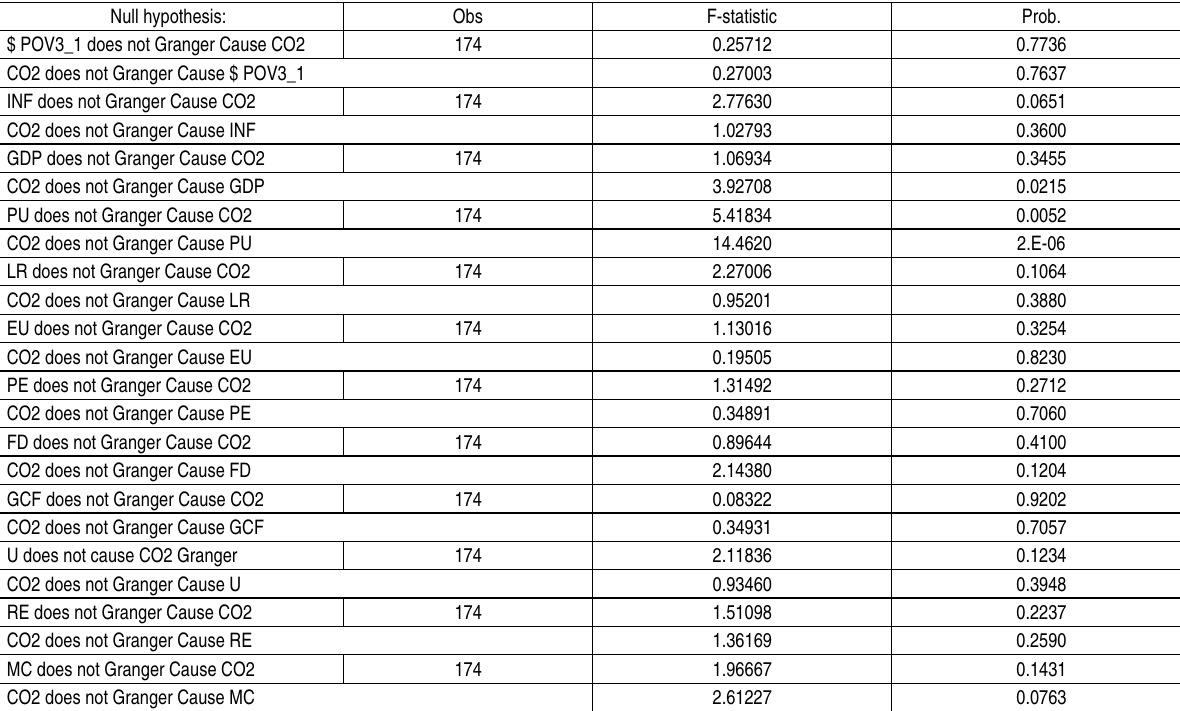
Table 9 (cont.). The causality test for variable